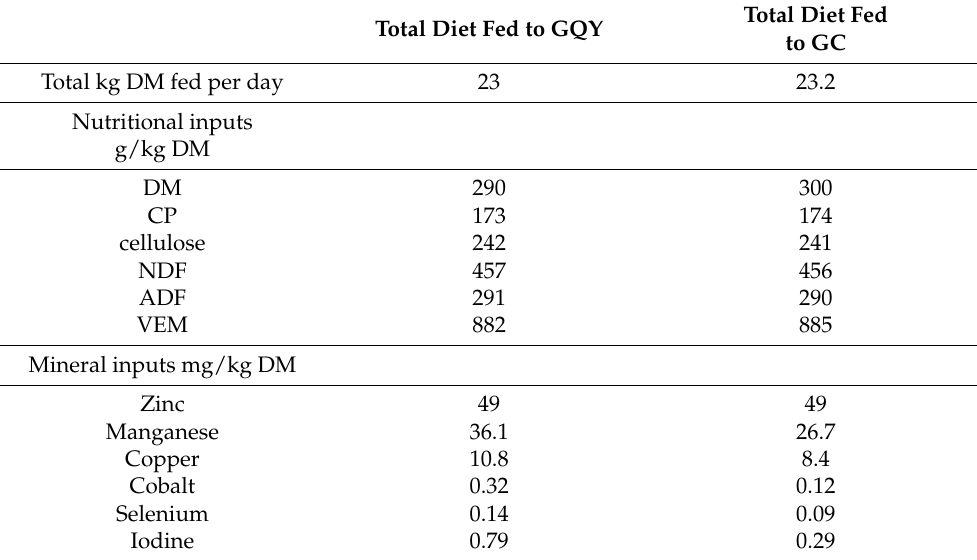
Table 6. Total nutritional inputs from the diets fed to each group, i.e., GQY and GC based including 10.5 kg DM grazed grass and 11.2 kg cereal crop silage. Concentrate complementation: 1.2 kg DM for GQY and 1.49 kg DM for GC.